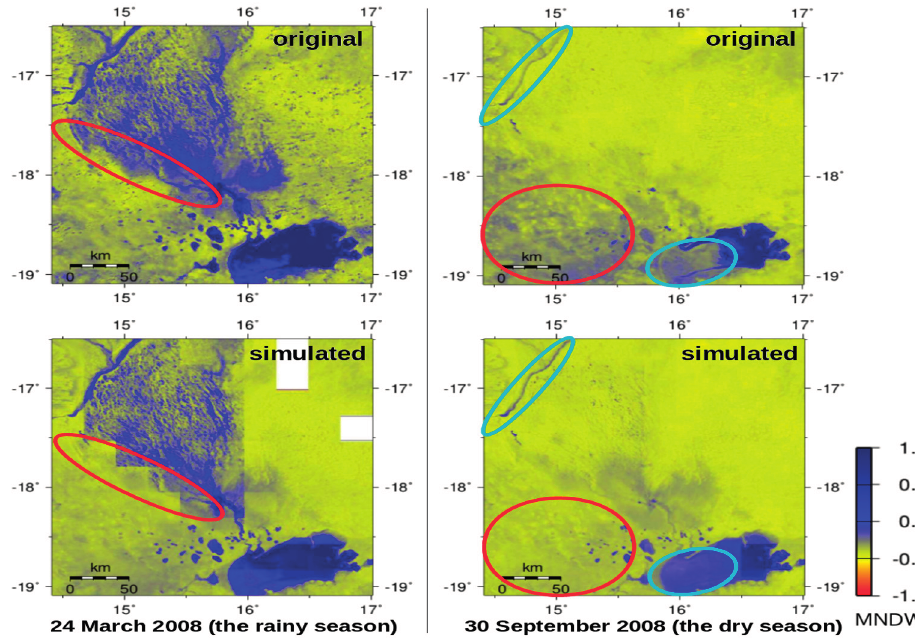
Figure 9. Comparison between (top) the original MNDWI maps and (bottom) the fully gap-filled (simulated) MNDWI maps for two days. During the rainy season (24 March 2008) there were some failures (null pixels) in the gap-filling. The red circles represent areas with MNDWI values lower than the original value; the blue circles represent areas with MNDWI greater than the original